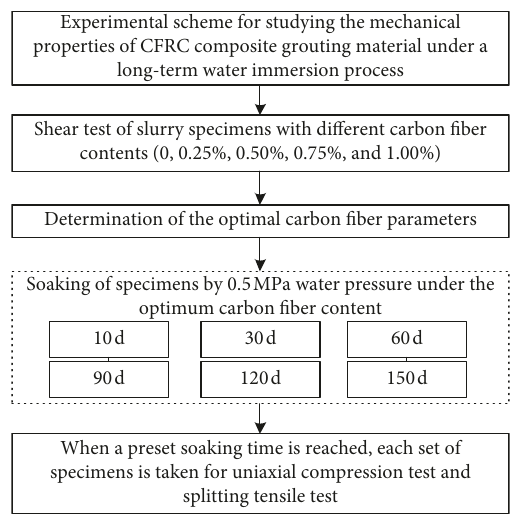
Figure 2: Experimental program.